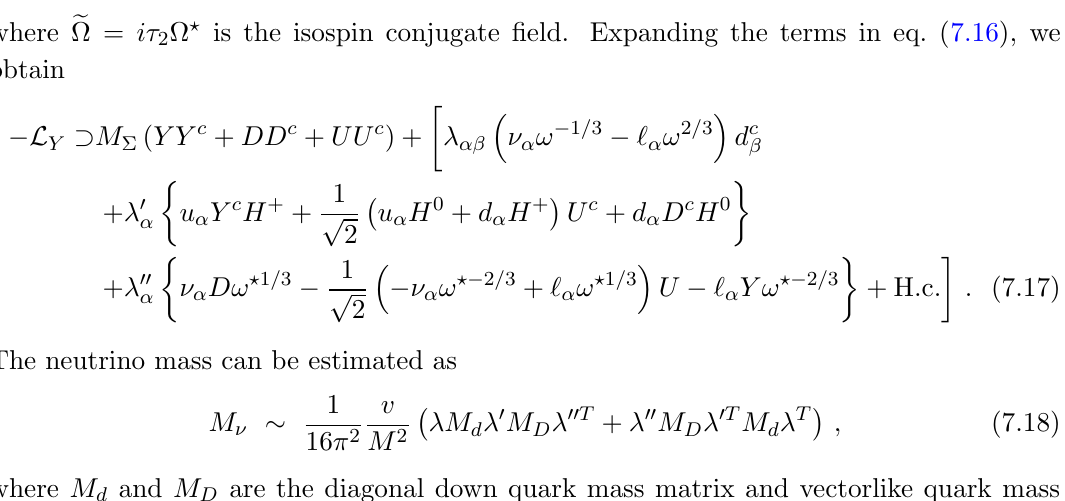
Figure 40 . Neutrino mass generation in the one-loop doublet LQ model with vectorlike quarks. 6 This is the model of table 3 3 O